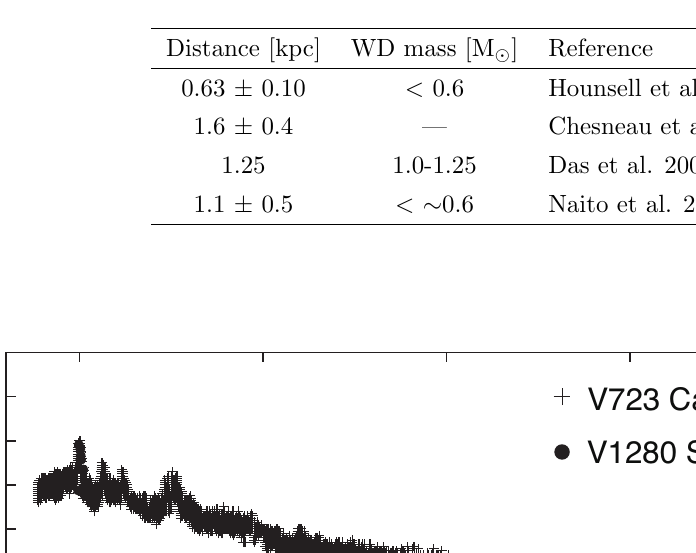
Table 1: Parameters of V1280 Sco in the literatures